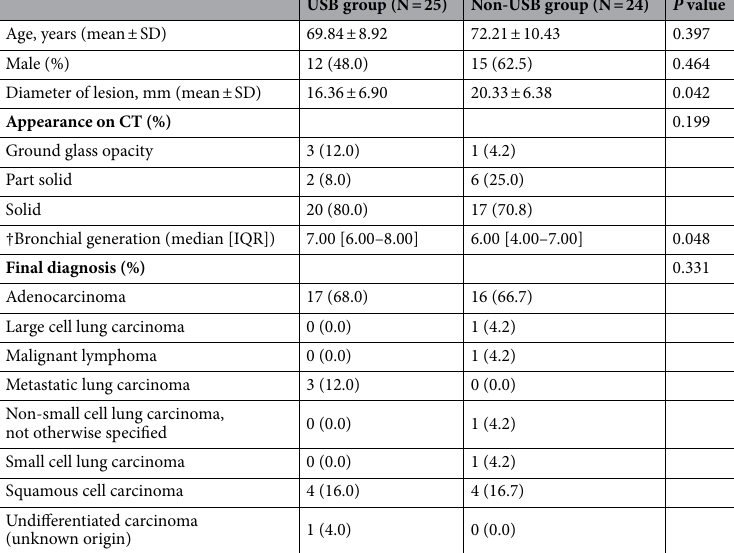
Table 1. Patient characteristics. CT computed tomography; DOM direct oblique method; IQR interquartile range; SD standard deviation. † Bronchial generation nearest or leading to the target, counted by DOM. Fisher’s exact test or the chi-square test was performed for categorical variables, as appropriate, and Student’s t-test and the Mann–Whitney U test were performed for continuous variables, as appropriate.